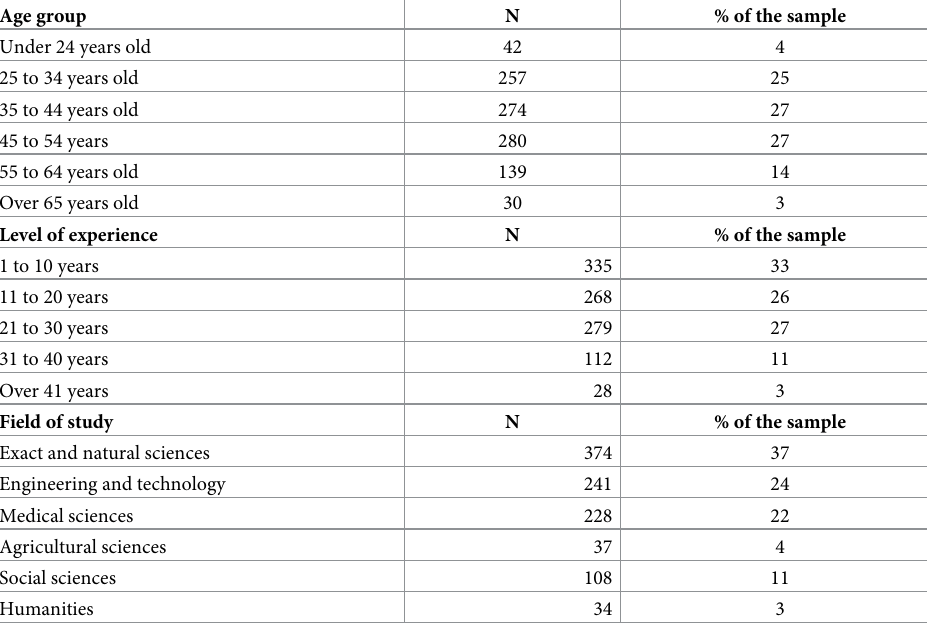
Table 2. Age, research experience and field of study. Age group N % of the